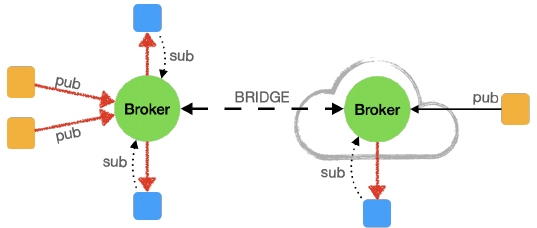
Figure 4. An MQTT Brokers